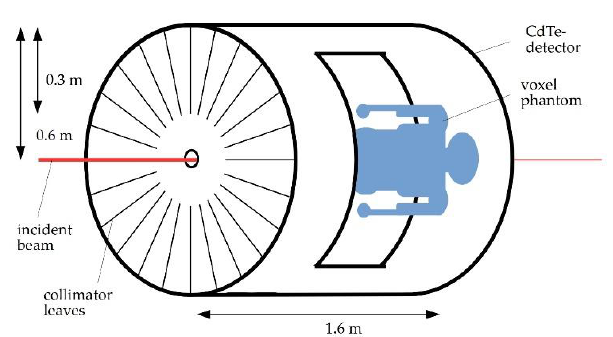
Figure 1. Schematic of simulated setup. 4 π -detector consists of Cadmium-Telluride and its Collimator consists of 3600 Molybdenum leaves. Detector has form of a cylinder, with holes on both sides to fit voxel phantom in. In this case, holes are 26.75 × 106.45 cm wide to enable sidewards mobility of phantom for scanning several positions. Red line shows incident pencil-beam with a diameter of 1 mm, radially extending lines show a simplified arrangement of collimator leaves. Blue shape illustrates how voxel phantom is placed inside tube such that beam axis extends sagittally through it.